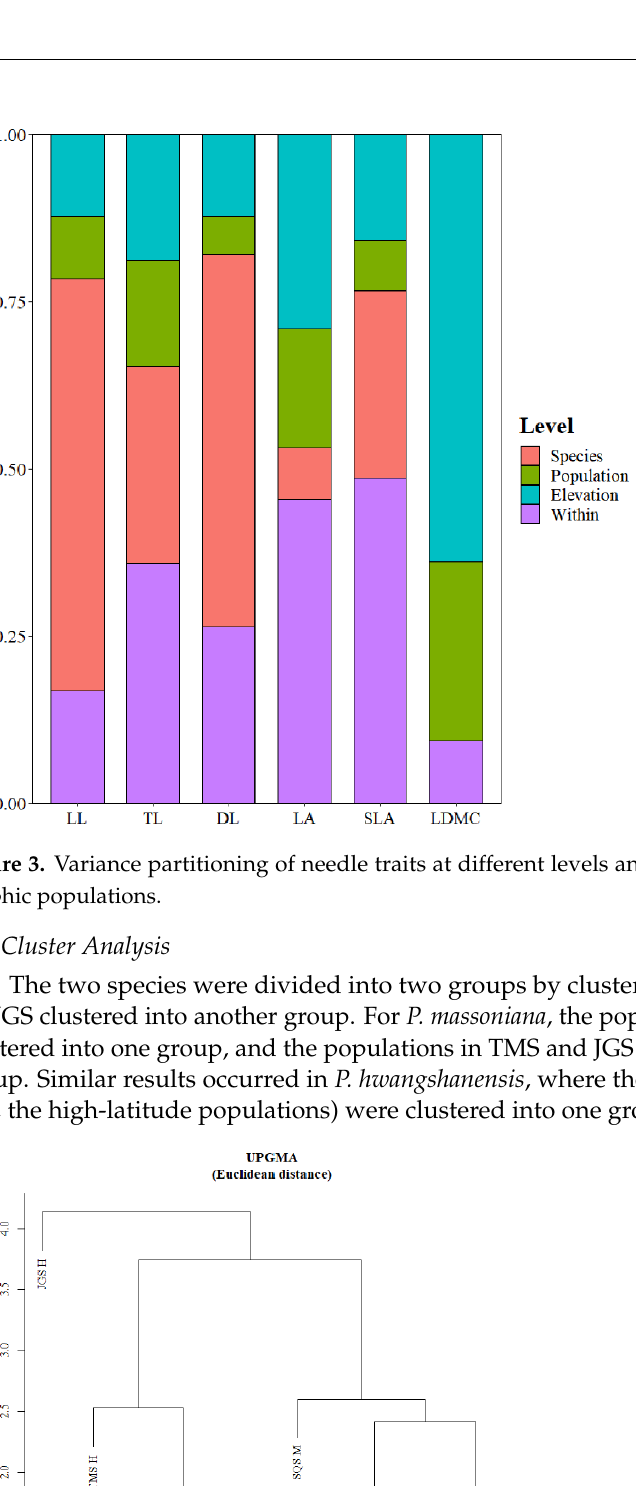
( b ) Figure 5. Redundancy analysis based on needle traits of ( a ) P. massoniana and ( b ) P. hwangshanensis . Abbreviations: Lon: longitude, La: latitude, ELE: elevation, MAT: annual average temperature, MAP: annual precipitation.